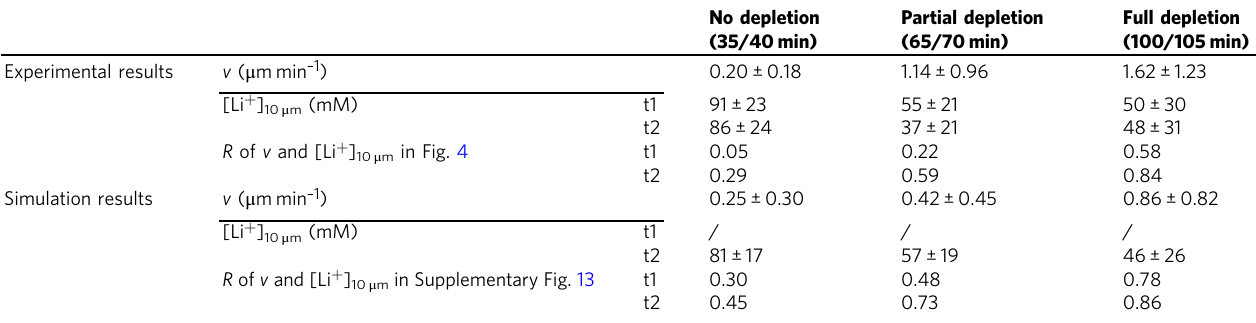
Table 1 Correlation between the local Li growth rate and Li + concentration